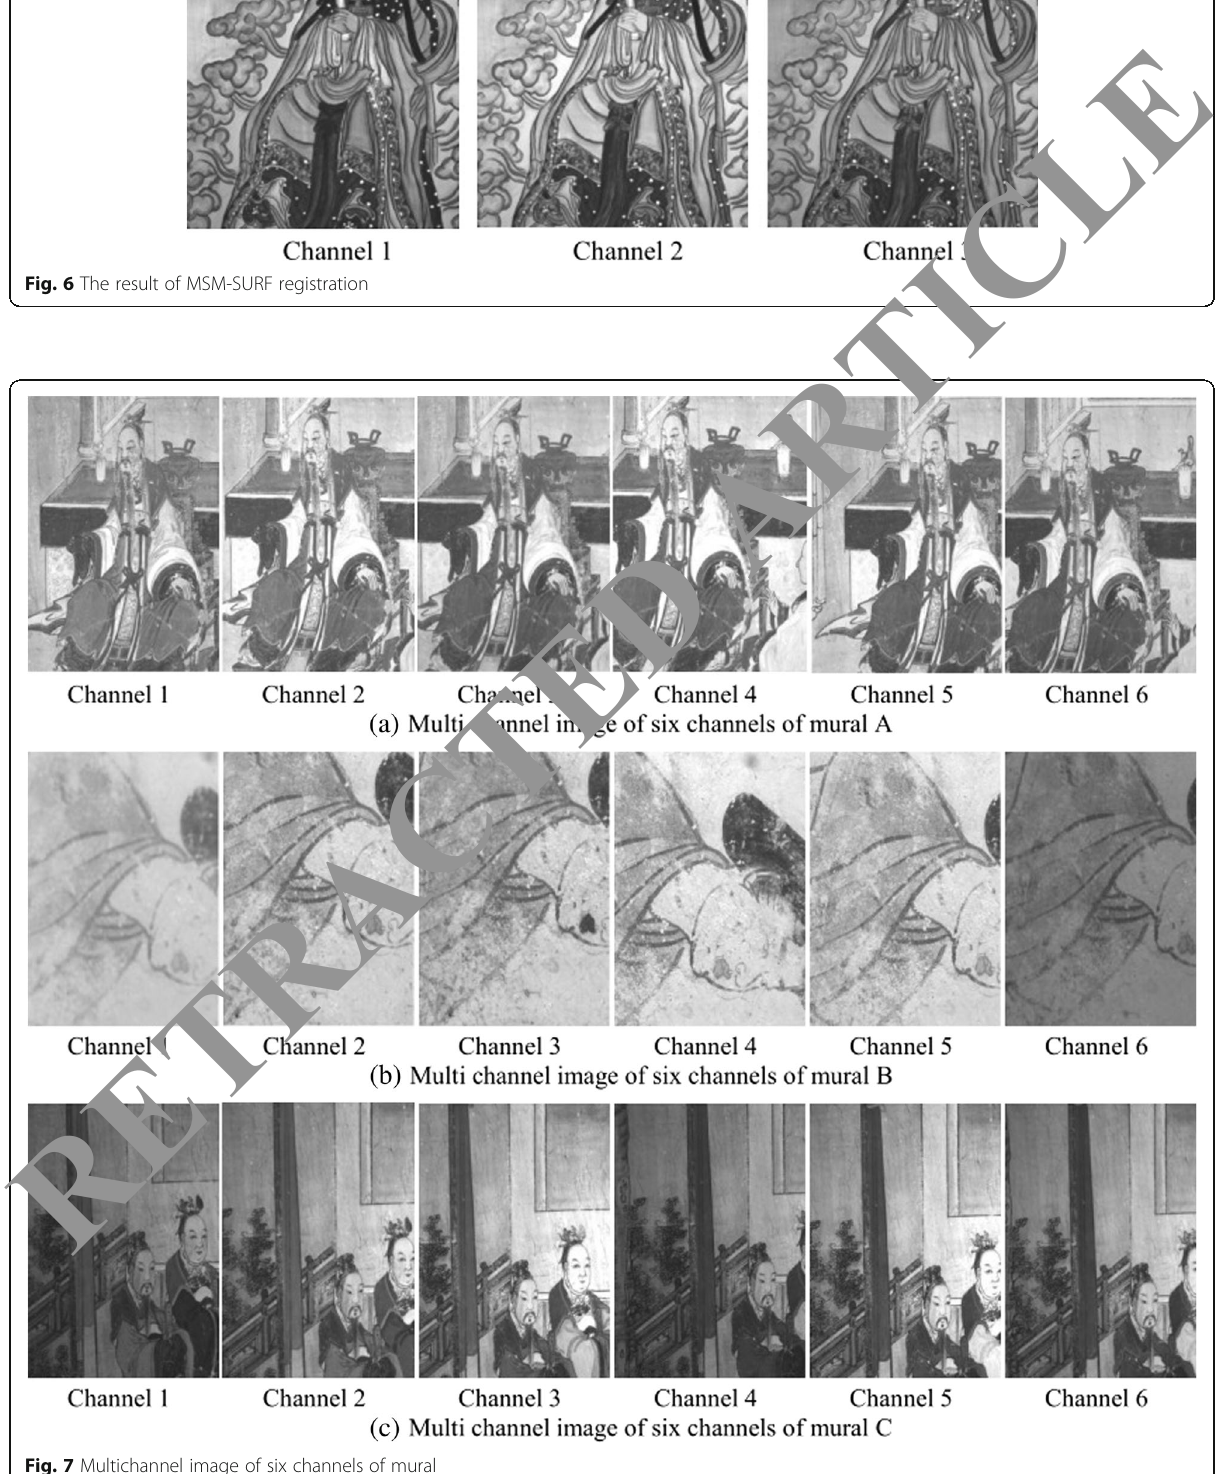
Fig. 7 Multichannel image of six channels of